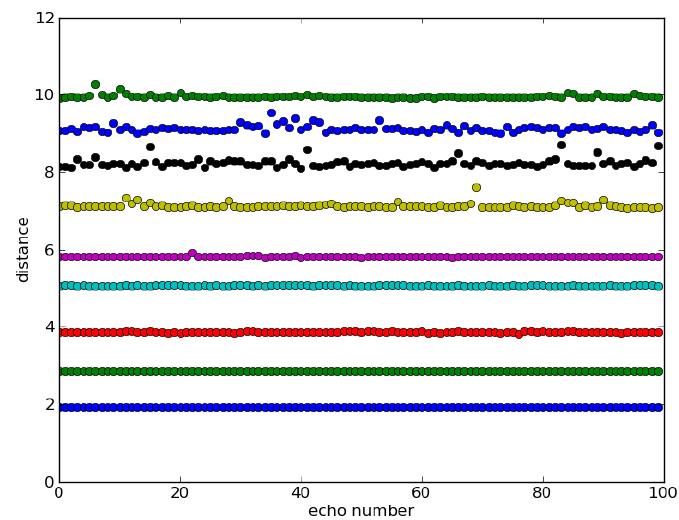
Figure 7. Measured distances from the sensor to a parked vehicle.